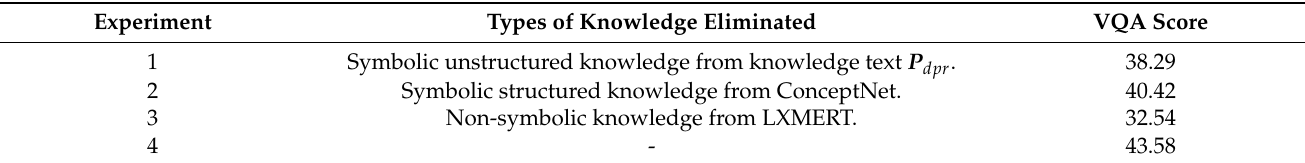
Table 4. The influence of varied types of